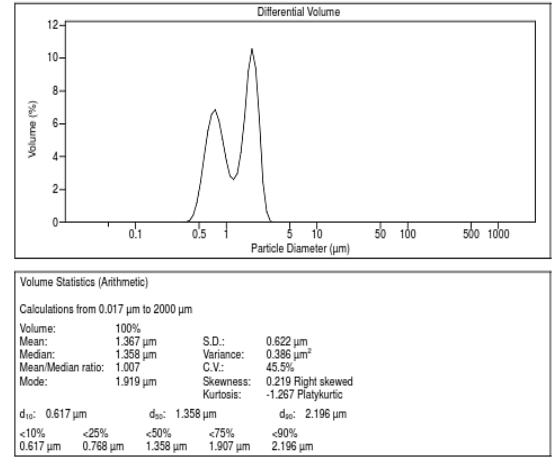
Figure 1. The PSA analysis result of